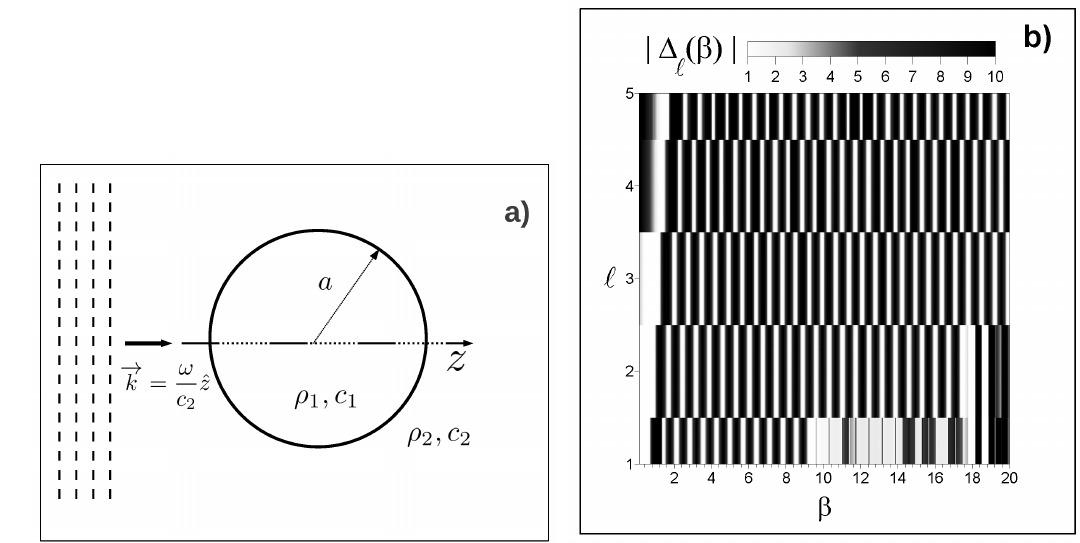
Figure 1 - The left panel ( a ) shows the scattering geometry, for an incident acoustic plane wave with related wave vector (cid:126)k . The incident wave reaches a spherical gaseous bubble of radius r = a surrounded by unbounded liquid water. Being the related sound velocity c 1 = 340 m / s and c 2 = 1500 m / s as well as the assumption of the densities values as ρ 1 = 1 . 269 kg / m 3 and ρ 2 = 999 . 972 kg / m 3 respectively. The right panel ( b ) shows for this scattering scenario, the strong oscillating behavior of the transcendental equation (see Eq. 13) ∆ (cid:96) ( β ) in the plane [ (cid:96), β ] . In this gray scale color map, the white color is related to values of | ∆ (cid:96) ( β ) | < 1 and the black color as | ∆ (cid:96) ( β ) | > 10